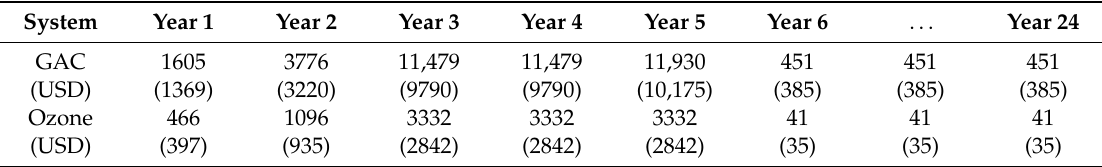
Table 8. Cost flows for the two advanced water treatment